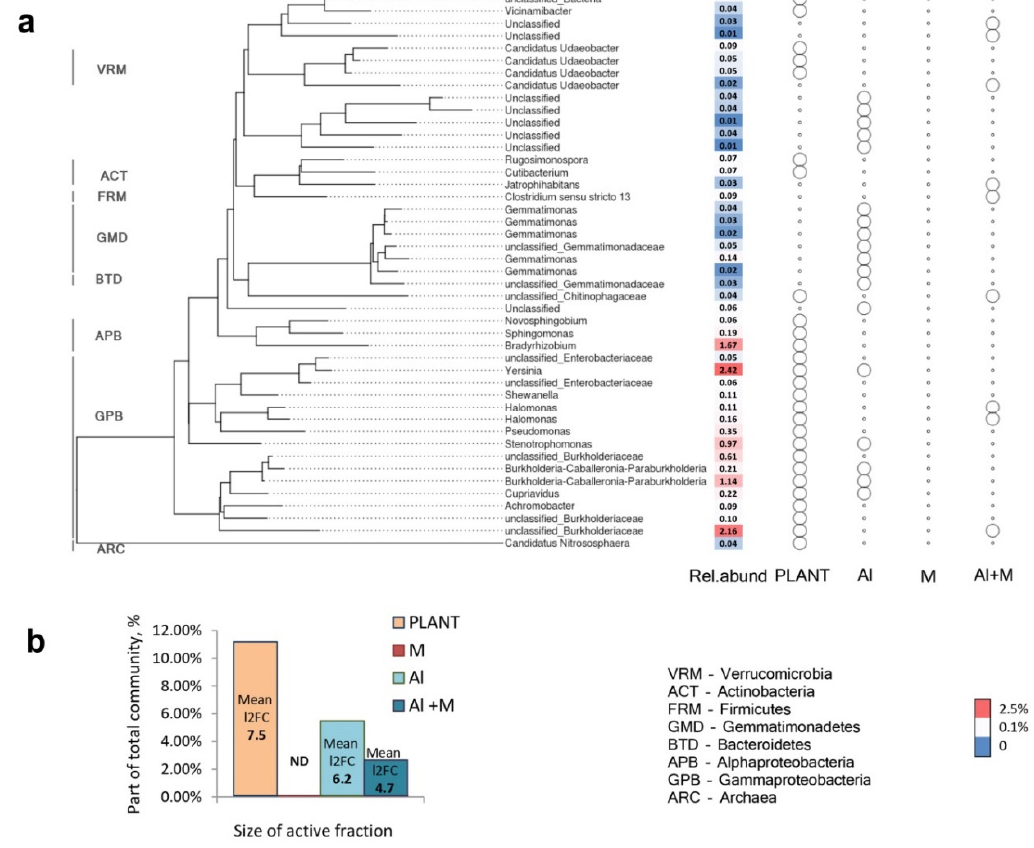
Figure 10. Phylogenetic tree of an “Active” microbiome fraction ( a ) and the size of an “Active” fraction as the percent of the total community a ff ected by the particular factor ( b ). Factors: PLANT—pea genotype, Al—aluminium supplement of soil, M—inoculation with microbial consortium, Al + M—interaction between aluminium supplement of soil and inoculation with microbial consortium. On the right side of the tree the presence (big empty cycle) or the absence (small empty cycle) of each phylotype in an “Active” microbiome fraction for each factor are shown. ND stands for not detected. Column “Rel.abund” shows phylotype’s relative abundance in total community (see scale bottom right). l2FC means the magnitude of shift in response to each factor as an averaged log2-fold change value for all “active”